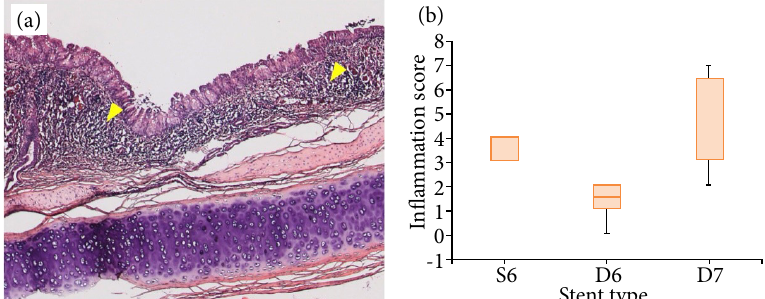
Figure 9 - Inflammation around the stent insertion site. (a) Infiltration of inflammatory cells was observed in the submucosal layer after stent implantation in group A (Yellow arrow heads). (b) Boxplot of inflammation scores of the stented trachea. The inflammation score was the lowest in group